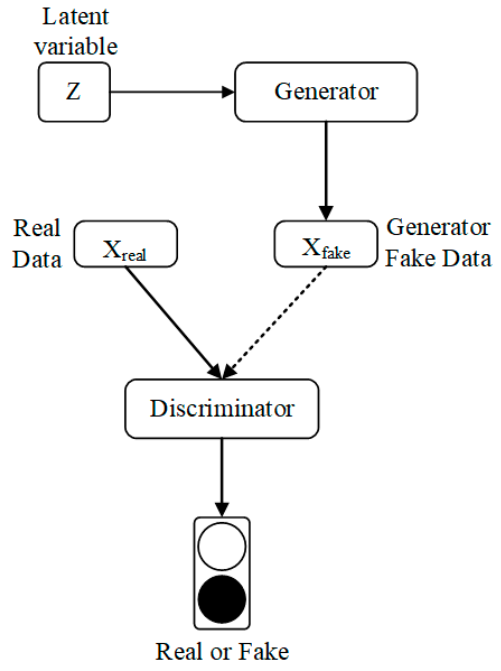
Figure 1. Schematic diagram of the structure of GAN.